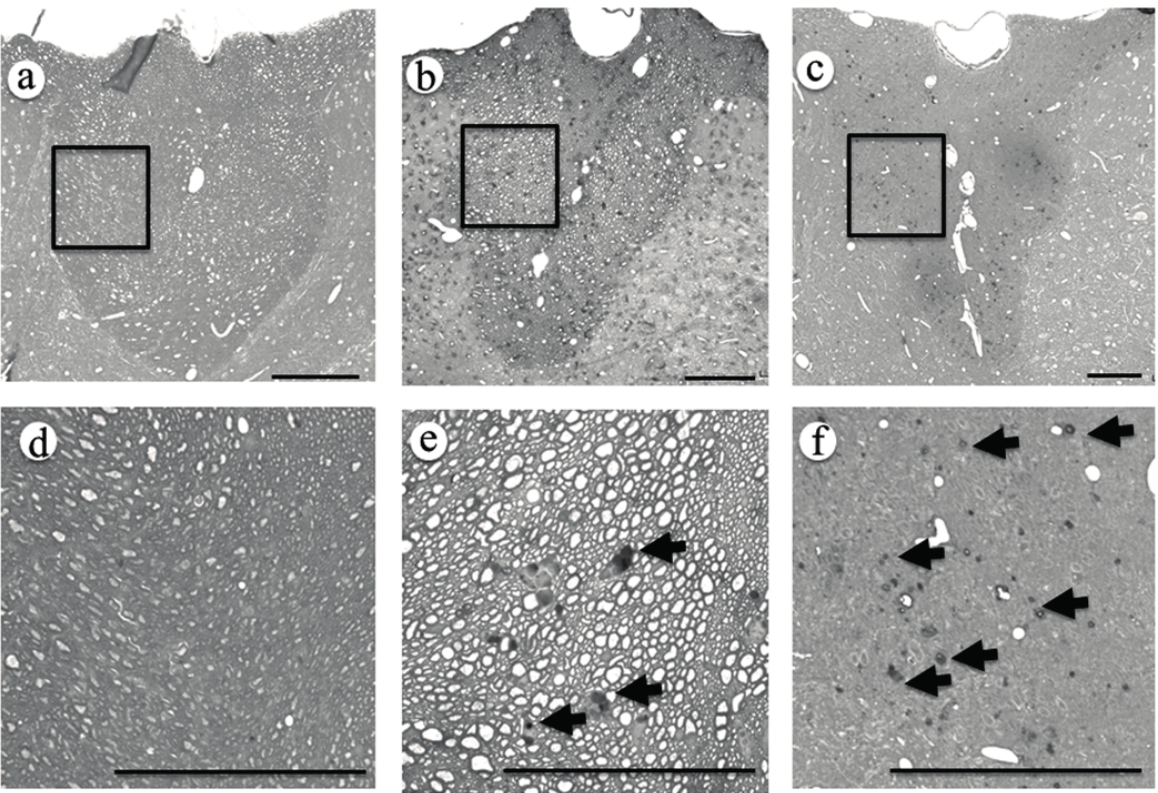
Figure 4. Dorsal funiculi of spinal cord before ( a , d ), three days ( b , e ), and seven days ( c , f ) after contusion injury. Images ( d – f ) were high magnification images of areas boxed in ( a – c ), respectively. Degenerated nerve fibers (arrows) were observed in dorsal funiculi three days and seven days after injury. Scale bar is 100 μ